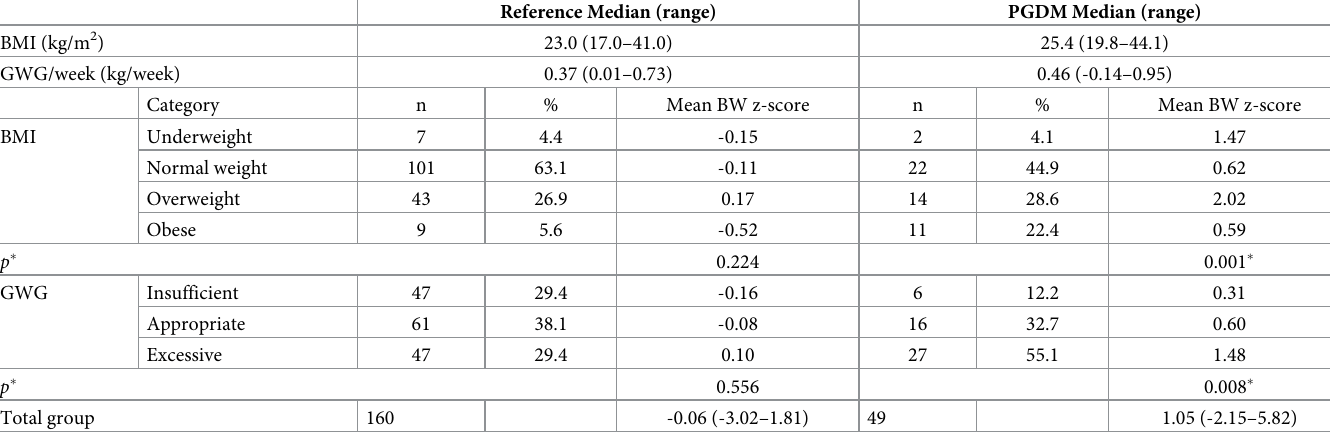
Table 4. Distribution of BMI categories, gestational weight gain categories, and birthweight z-scores in the reference and the pregestational diabetes mellitus popu- lation (160 and 49 participants,